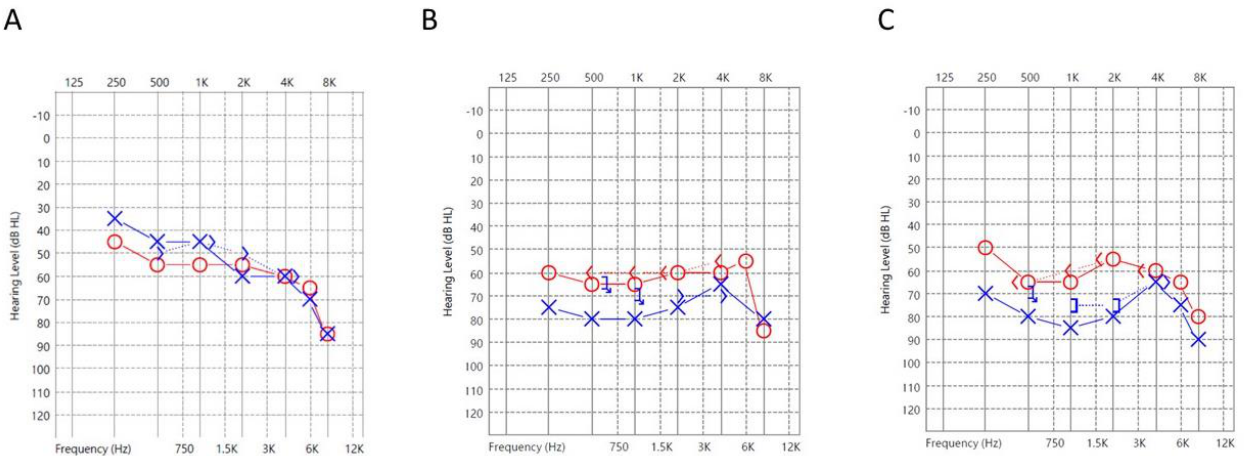
Figure 2. Audiograms of Patient 2 with positive PCR: ( A ) at presentation and ( B ) 2 months after treatment. (O: Unmasked air conduction thresholds in the right ear; X: Unmasked air conduction in the left ear; [: Masked bone conduction in the right ear; Δ : Masked air conduction in the right ear; Arrows (on any symbol): No response).